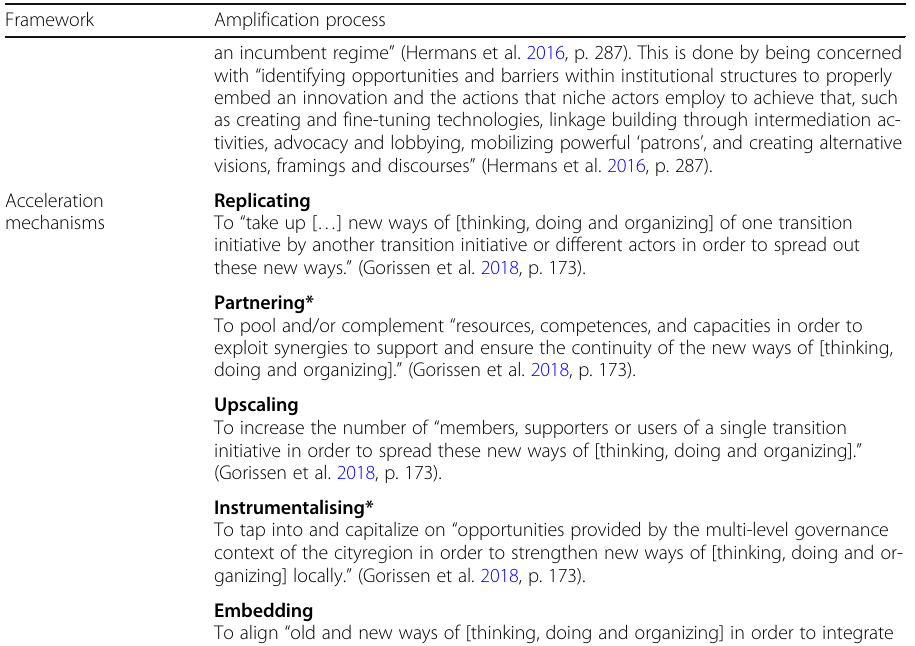
Table 2 Amplification processes from the different frameworks (*Not used in analysis because this process does not focus specifically on increasing impact)